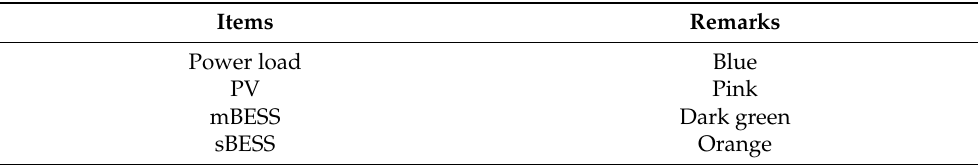
Table 1. Expressions of simulation results.